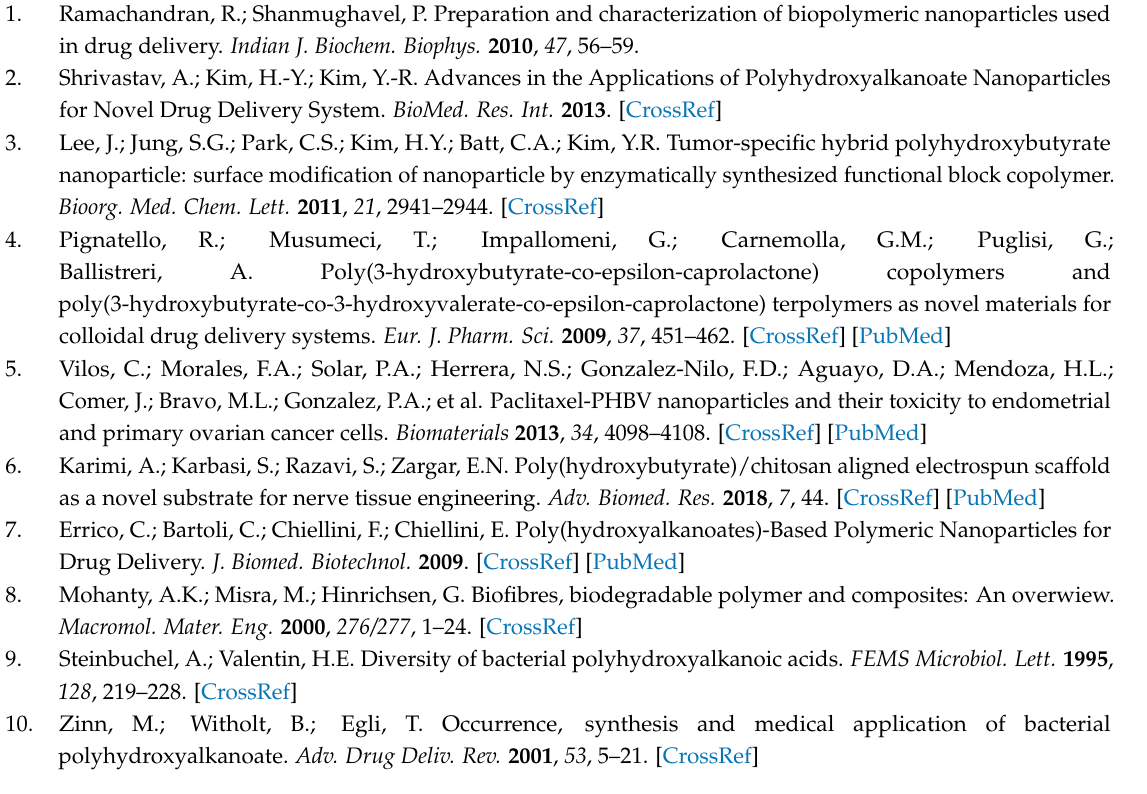
Figure S1: The chemical structure of the PHA used in this study, and its 500 MHz 1 H NMR spectrum in CDCl 3 , with assignments. The m index may take the values 1, 3, and 5, and the n index, 0, 2, and 4. The singlet peak with an asterisk at 2.17 ppm is due to acetone. Figure S2: Schematic illustration of the cross-linking process of uns-PHA under the effect of